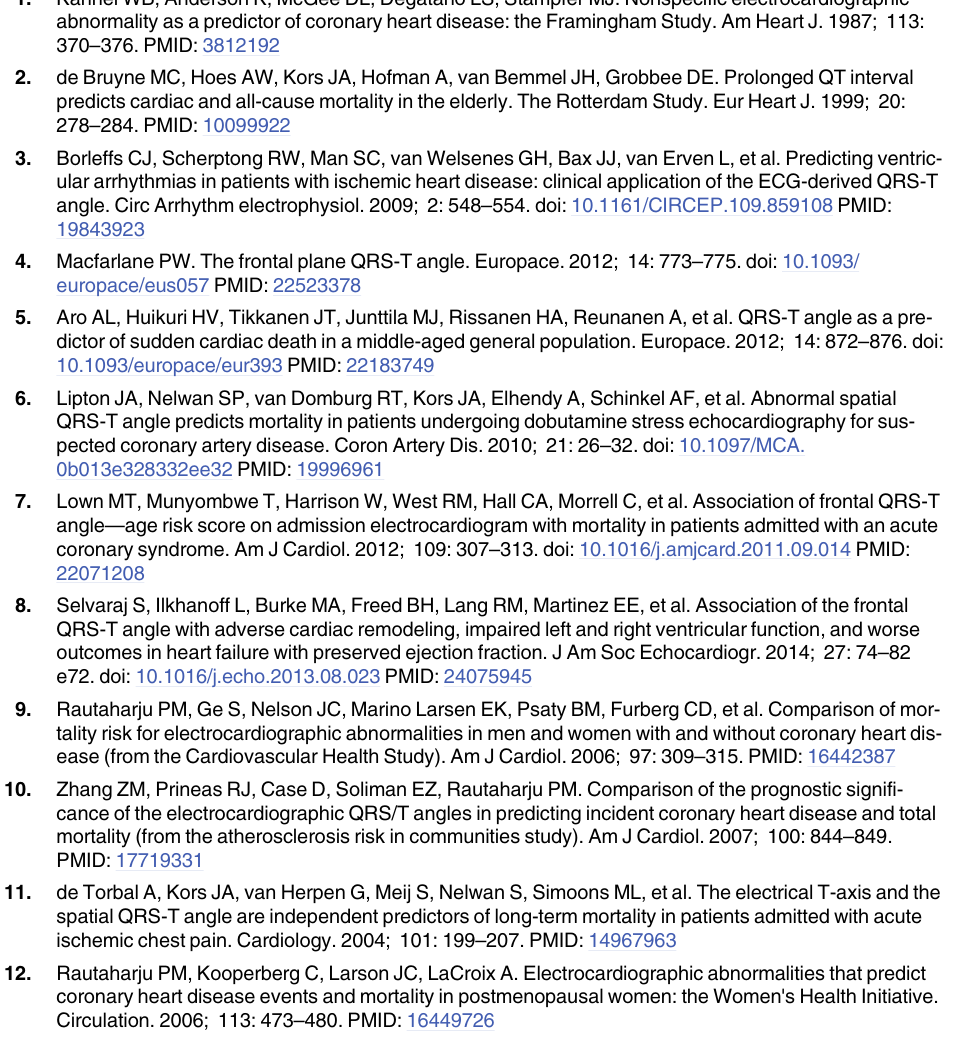
S2 Table. Unadjusted results of meta-analyses for spatial/frontal QRS-T angle and all-cause mortality/cardiac